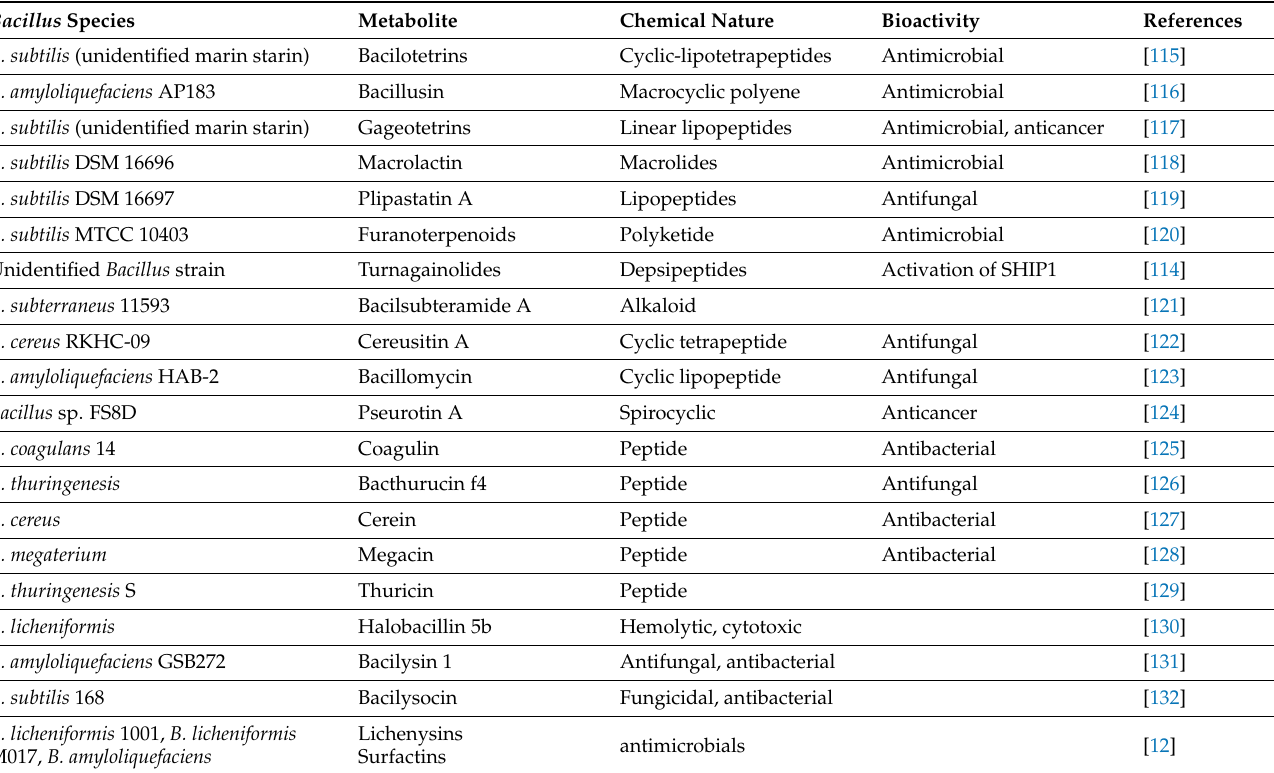
Table 3. Identified metabolites in the intracellular and extracellular chemical space of Bacillus